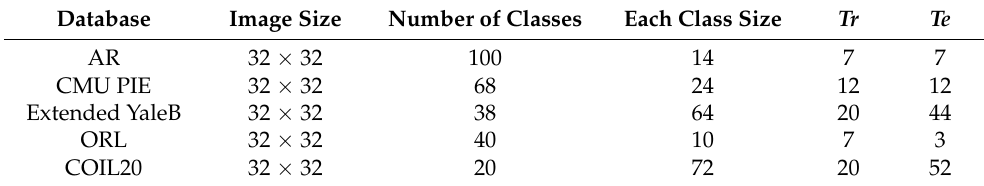
Table 5. Details of five databases.